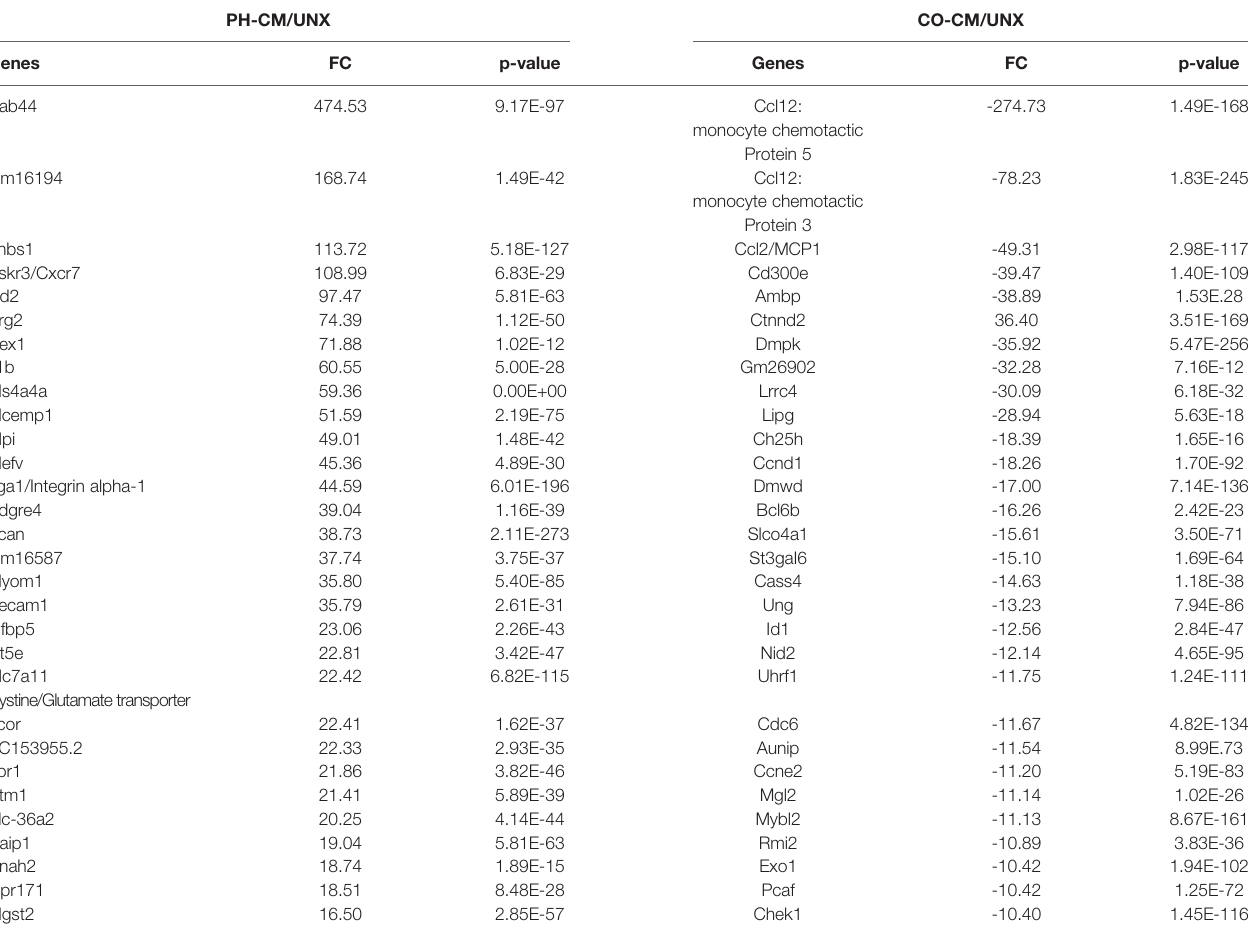
TABLE 1 | Top 30 genes up-regulated by PH-CM and down-regulated by CO-CM in